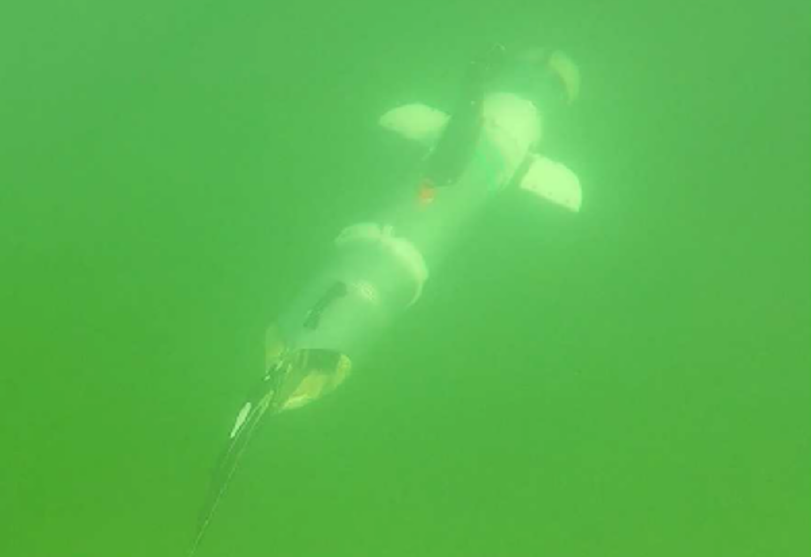
Figure 1. Image of the autonomous underwater vehicle achieved from vision